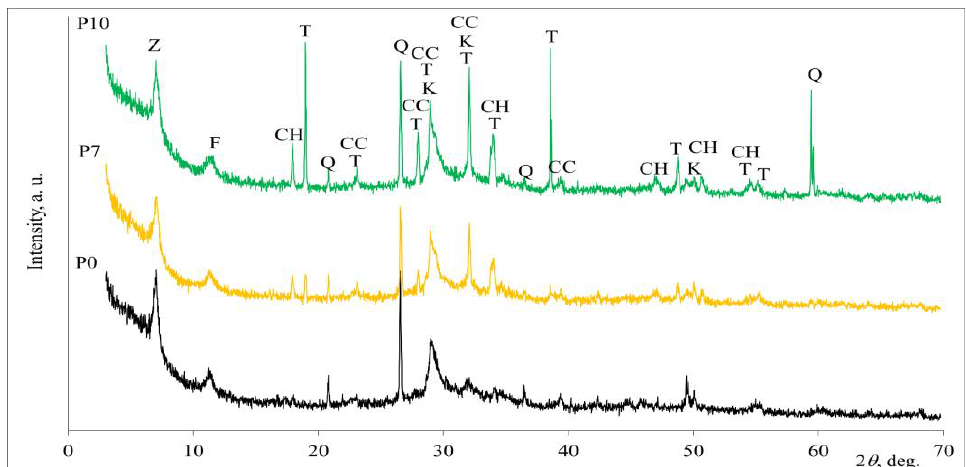
Figure 10. X-ray diffraction patterns of porous alkali-activated slag. Notes: Z—sodium aluminum silicate hydrate, Na 96 Al 96 Si 96 O 384 216H 2 O (39-222); K—calcium silicate hydrate, Ca 1.5 SiO 3.5 H 2 O (33– 306); Q—quartz, SiO 2 (83–539); T—thenardite, Na 2 SO 4 (74–2036); CC—calcite, CaCO 3 (72–1937); F— hydrotalcite, Mg 6 Al 2 CO 3 (OH) 16 ·4H 2 O (14–191); CH—portlandite, Ca(OH) 2 (84–1268).